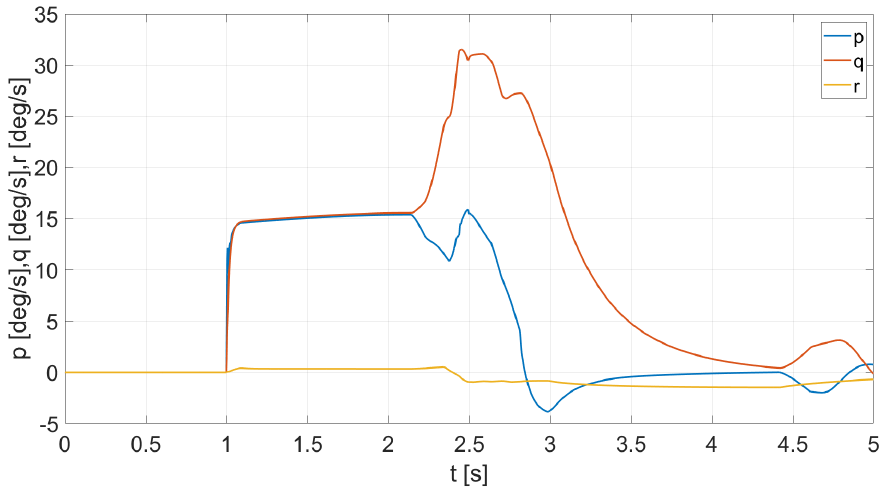
Figure 6. UAV angular speed response—PID-SDRE control mode, t f = 4